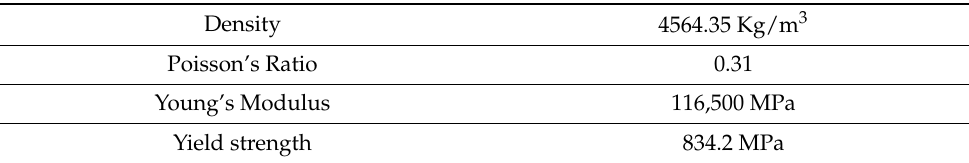
Table 2. Ti-6Al-4V material properties [31].